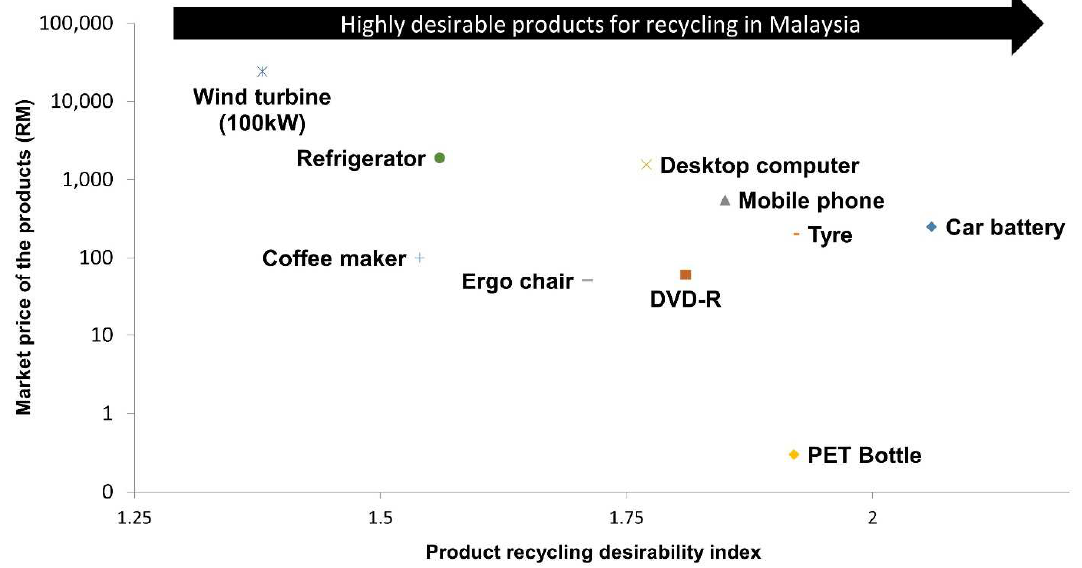
Figure 2. Product distributions based on desirability for recycling for Malaysia.